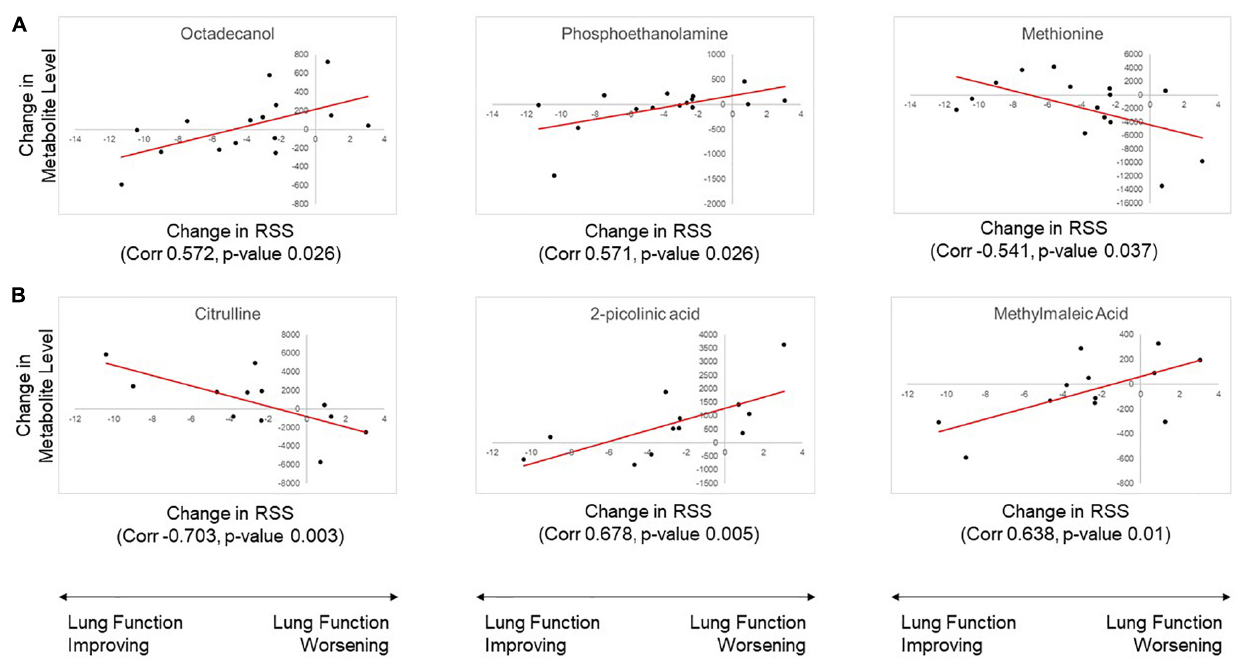
FIGURE 3 | Results of correlation analysis for change in metabolite level with change in Respiratory Severity Score (RSS). The three metabolites with the most significant correlation in (A) plasma and (B) urine samples are shown. Metabolite abundance is displayed with arbitrary units of measurement.